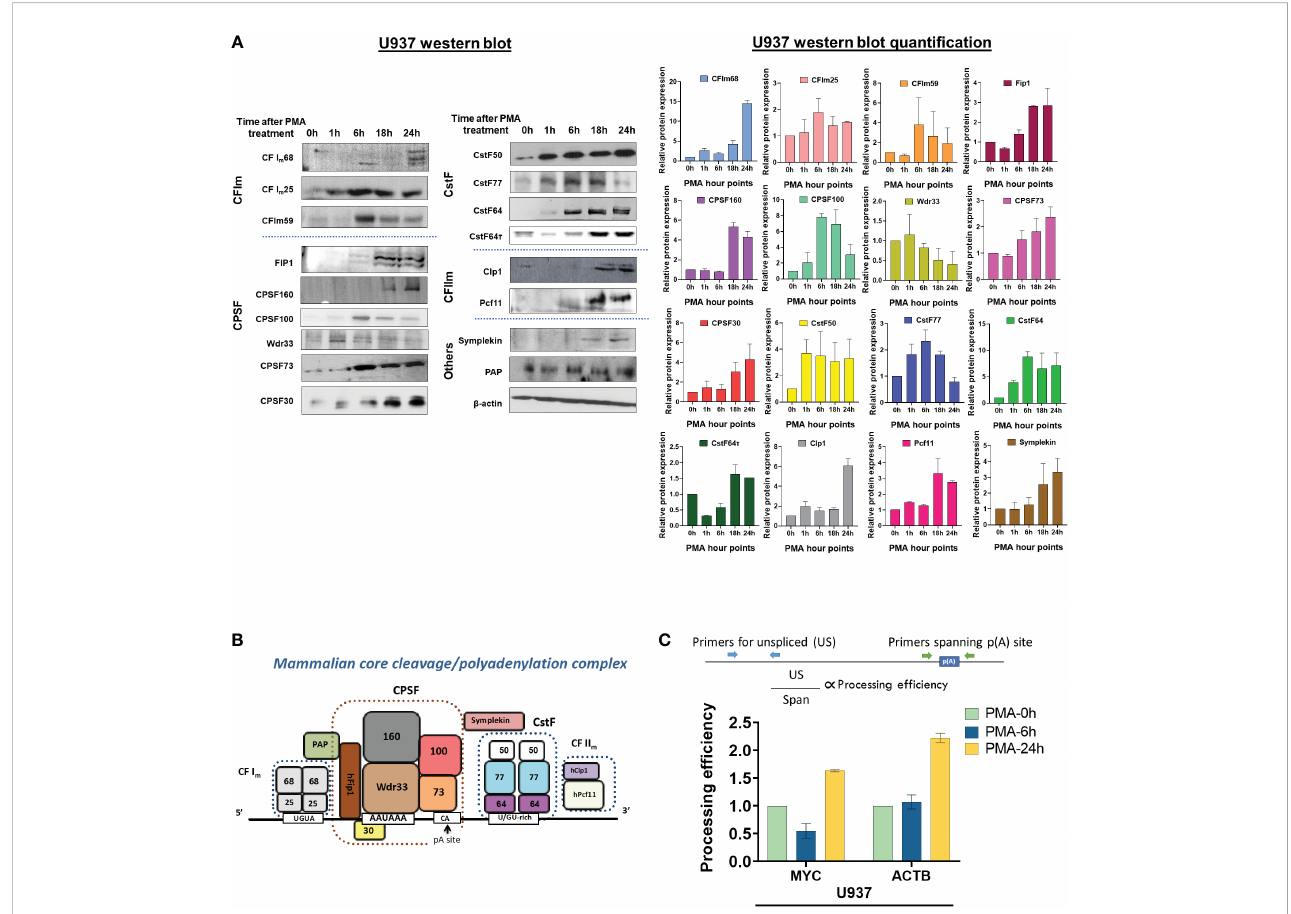
FIGURE 6 Effect of macrophage differentiation on the expression of C/P proteins in U937 cells. (A) Whole cell lysates from U937 cells treated with PMA for 0, 1, 6, 18 and 24 hours were separated by 10% SDS-PAGE and western blotting was performed for the indicated subunits of the C/P complex, with b -actin as the loading control. Each western blot (left panel) was performed in three biological replicates of the differentiation process and the quanti fi ed data is shown in the right panel. (B) Schematic of the mammalian core C/P complex. (C) Processing ef fi ciency of MYC and ACTB transcripts for U937 cells. The bar graph shows the ratio of unspliced (US) RNA transcripts (detected by RT-qPCR with a primer pair upstream of the poly(A) site) to unprocessed RNA (detected by RT-qPCR with a primer pair that spans the poly(A) site) as shown in the schematic. The cDNA preparation was done using random